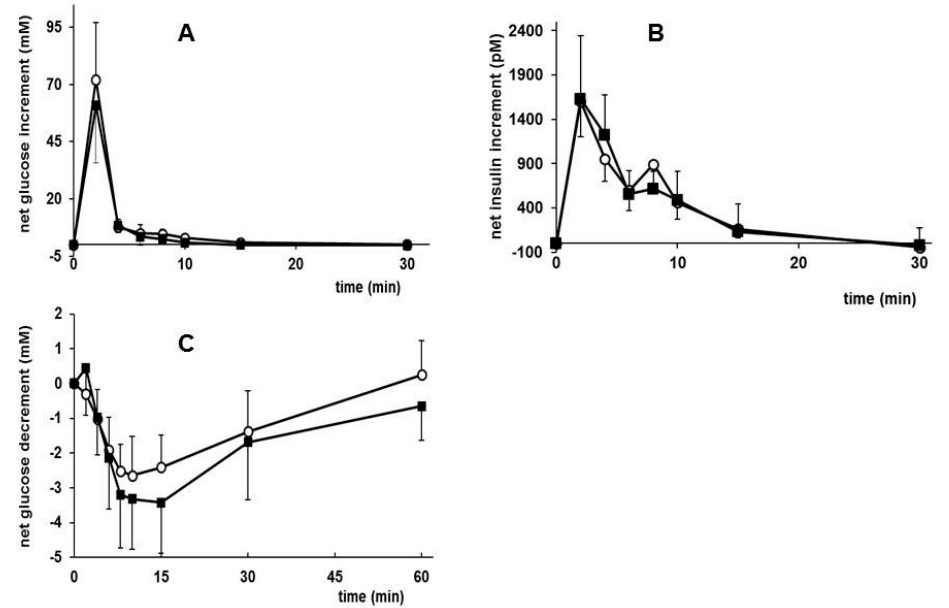
Figure 5. Results of the intravenous GTT (panel ( A ) and ( B )) and intravenous ITT (panel ( C )) carried out on PN day 84 and 90, respectively, in male rats fed a CTRL ( n = 11–12) or MCT diet ( n = 7–8) in early life (PN day 2–42). Values are means ± SD.